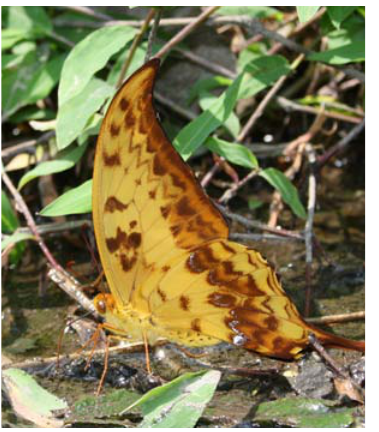
Image 10. Meandrusa payeni evan